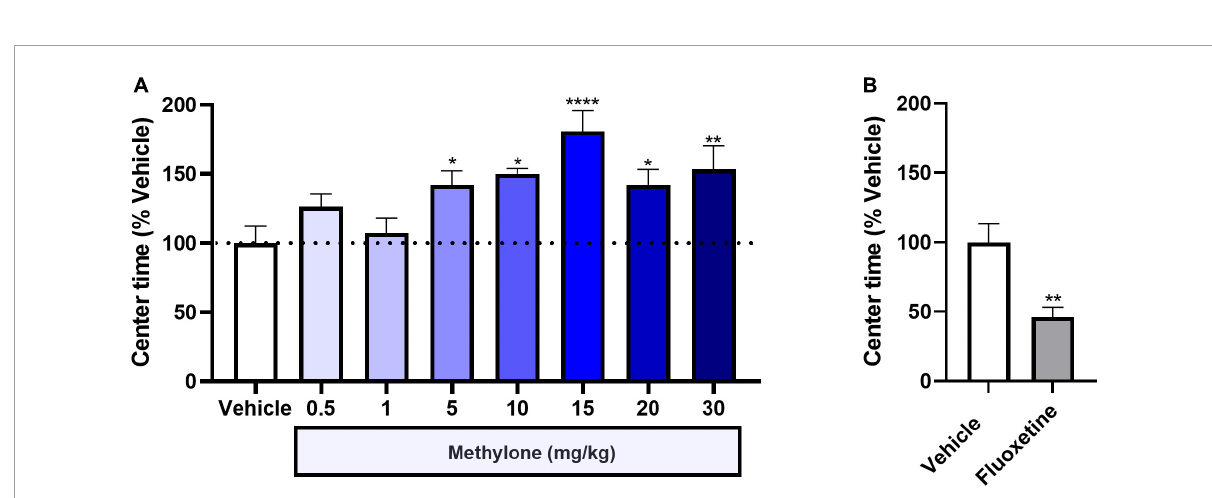
FIGURE5 Methylone shows anxiolytic activity, increasing the time spent in the center of the open field test. The time spent in the center of the OFT is shown 30-min post-dosing with (A) methylone or (B) fluoxetine. Data are presented as means ± SEM. * p < 0.05, ** p < 0.01, **** p < 0.0001, Fisher’s LSD post-hoc test; N = 6 for fluoxetine; N = 7–13 per group for